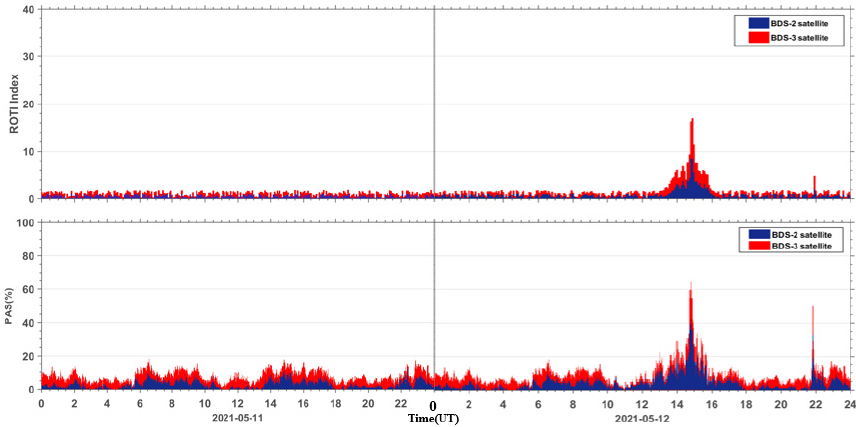
Figure 12. The comparison results of the ROTI index and the PAS index.